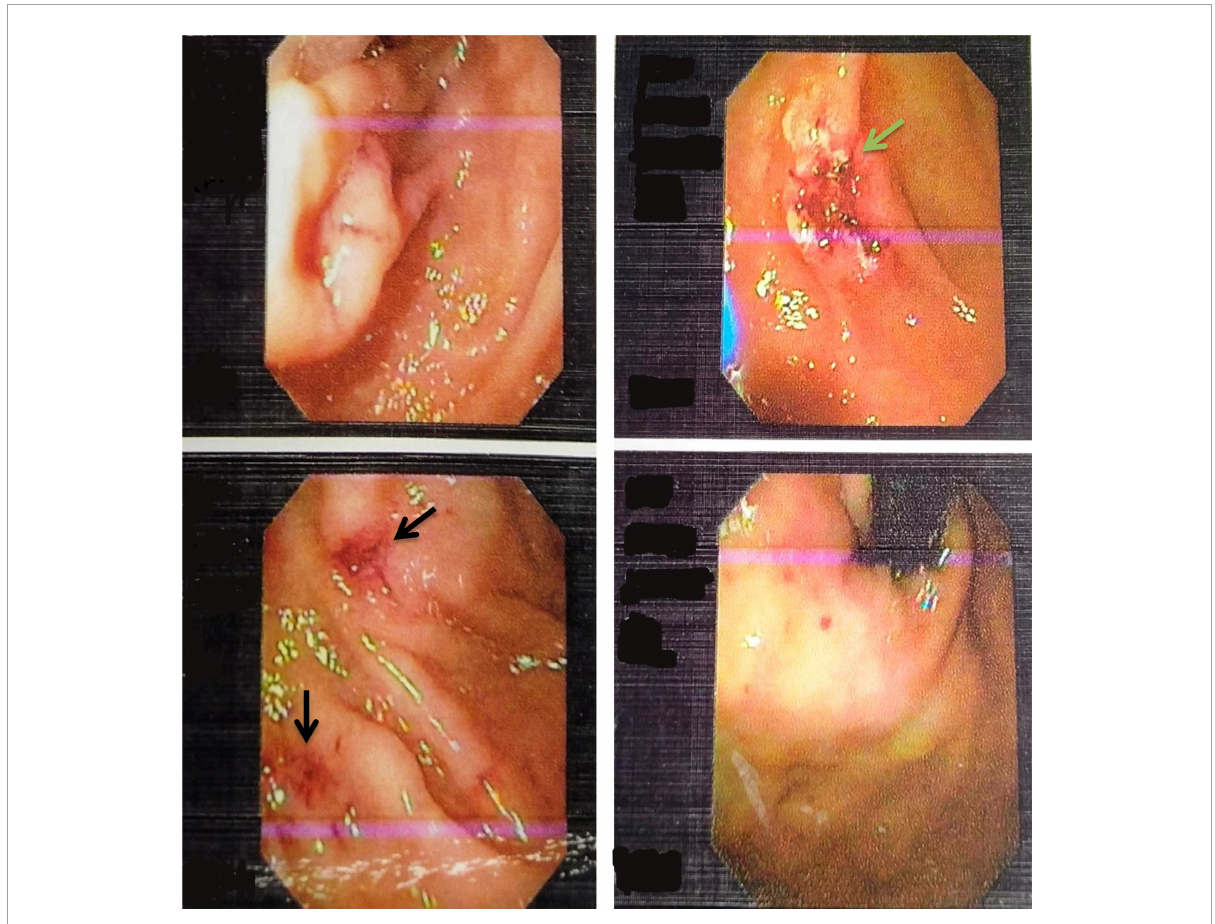
FIGURE1 Upper Gastrointestinal endoscopy images showing multiple telangiectasia in the stomach (black arrows) and ulcer located in the second part of the duodenum (green arrow).